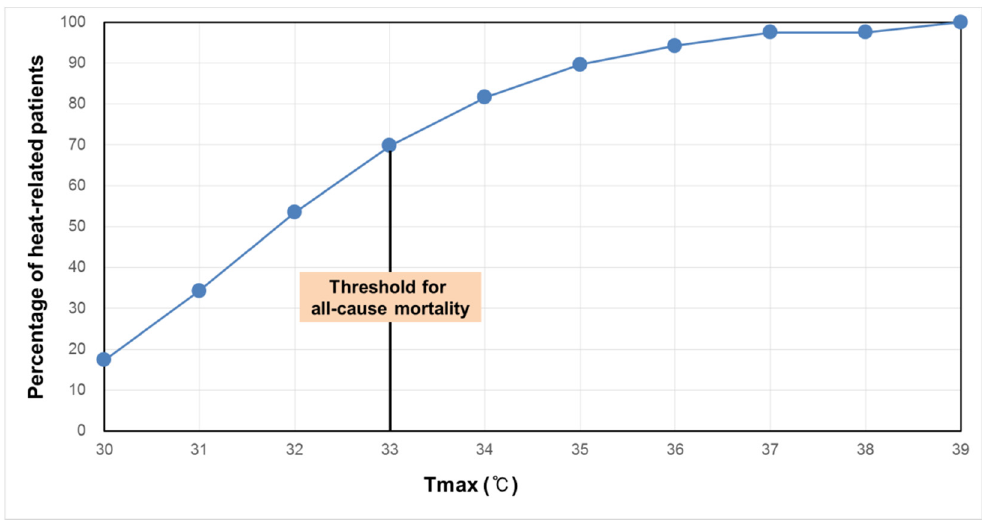
Figure 4. Cumulative number of heat-related morbidities with temperature increase above 30 °C, which is the threshold temperature for heat-related morbidity.